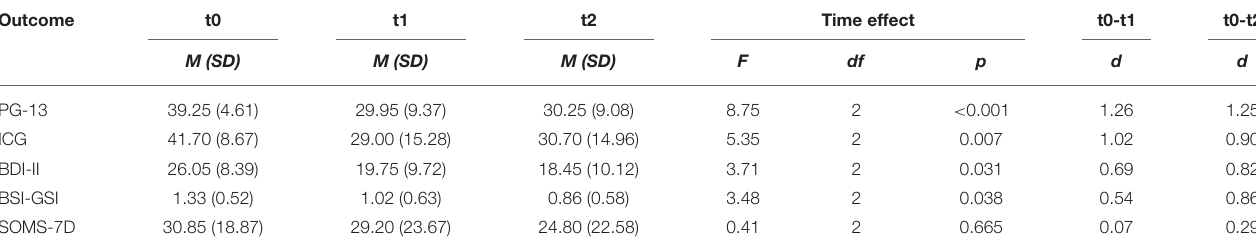
TABLE 3 | Primary and secondary outcomes of study participants in the feasibility trial of PCT adapted for PGD adults based on intent-to-treat analyses with LOCF, N = 20. Outcome t0 t1 t2